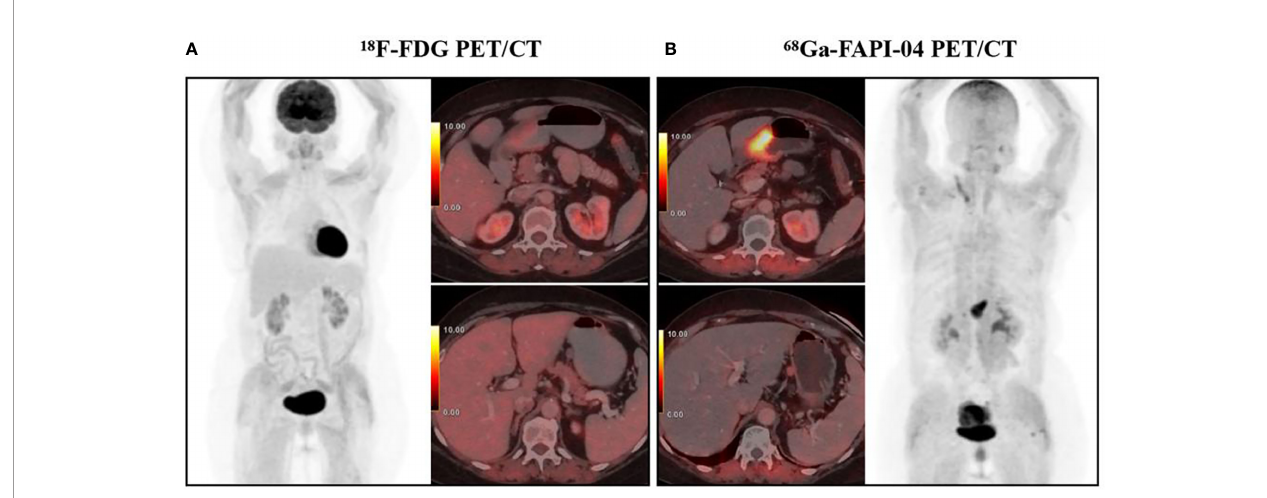
FIGURE 1 | A 65-year-old woman diagnosed with poorly differentiated gastric adenocarcinoma underwent 18 F-FDG PET/CT (A) and 68 Ga-FAPI-04 PET/CT examination (B) respectively, showing a FAPI-positive, FDG-negative primary tumor (SUV max 11.8 and 2.3, respectively) and a perigastric lymph node (SUV max 2.3 and 0.3, respectively). With permission from Kuten et al. (49).